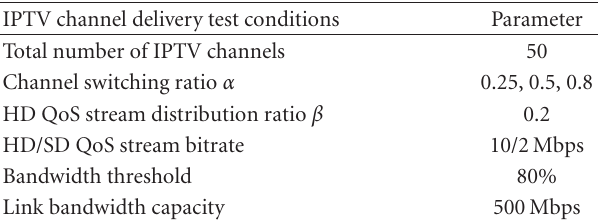
Table 1: IPTV multicast simulation parameters.